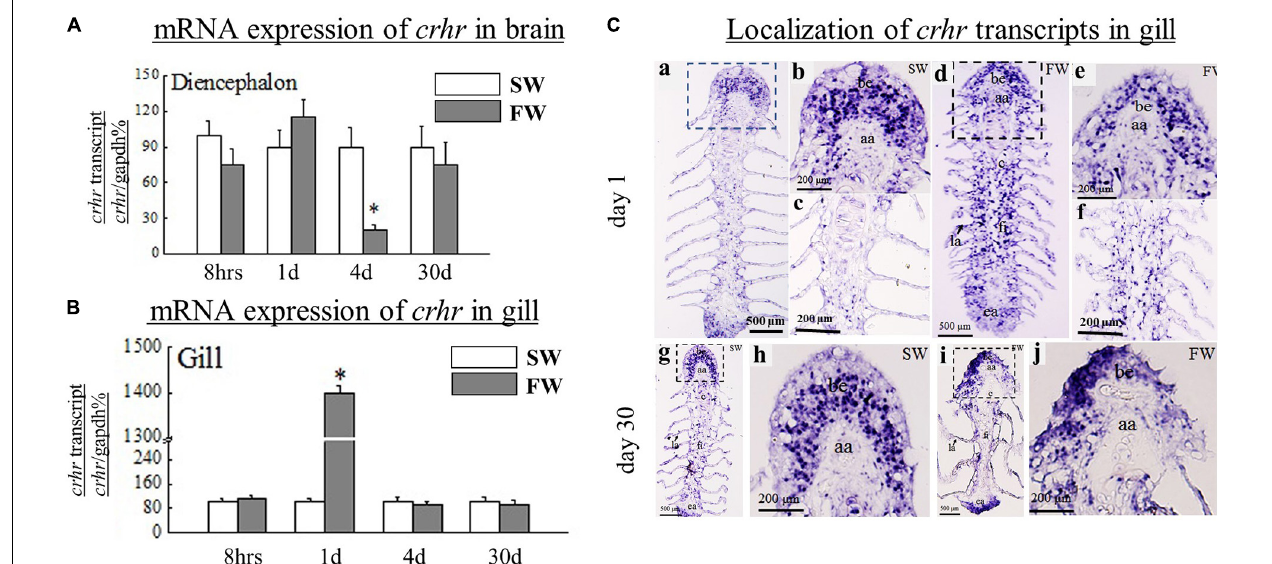
FIGURE 2 | (A) Comparative analysis of crhr , gene expressions as determined by quantitative real-time PCR in diencephalon (Dien) of black porgy from SW to FW at 8 h, day 1, day 4, and day 30. Each data had 10 fish. (B) Comparative analysis of crhr , gene expressions as determined by quantitative real-time PCR in the gill of black porgy from a SW to FW transfer at 8 h, day 1, day 4, and day 30. Each data had 10 fish. (C) The in situ hybridization was performed to localize crhr transcripts in black porgy gill during SW and FW acclimation on day 1 (a–f) and day 30 (g–j) . The mRNA expression of crhr signals was more abundant throughout the gill in FW-acclimated fish (d–f) compared to the SW fish (a–c) on day 1. On day 30, the hybridization signals of crhr were almost similar between SW (g,h) and FW (i,j) fish in the branchial epithelium of the gill. The representative fish is shown from one of 3 fish. There was no notable signal found in the representative sense pictures (not shown). aa, afferent artery; be, branchial epithelium; ea, efferent artery; fi, filament; la, lamellae. Student’s t -test was conducted to determine significant differences ( p < 0.05) between SW and FW denoted by asterisks